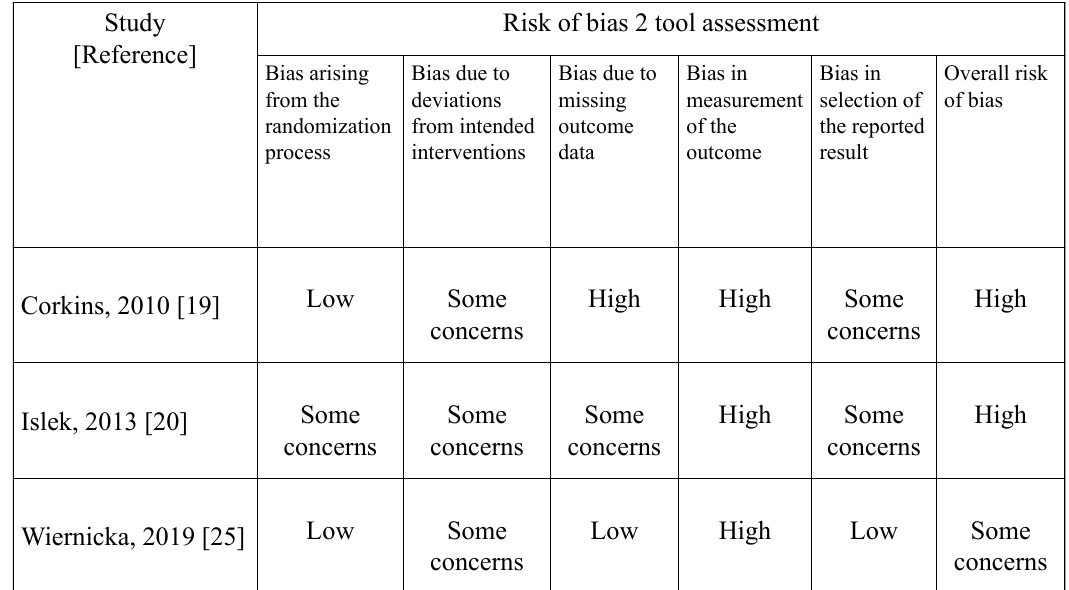
Figure A2. Risk of bias for vomiting events.